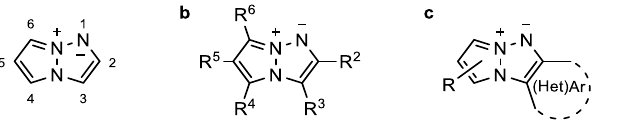
Figure 1. Numbering of the 1,3a,6a-triazapentalene (TAP) core ( a ) and the general structures of non-fused TAPs ( b ) and (hetero)aryl-fused TAPs ( c ).